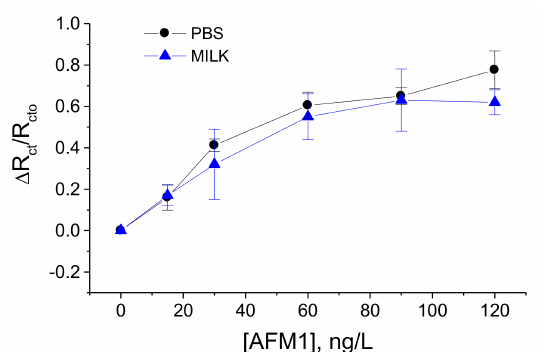
Figure 6. Plot of the relative changes of R ct values vs. concentration of AFM1 ( ∆ R ct /R cto = (R ct − R cto )/R cto , where R cto , R ct are charge transfer resistances without and with certain concentration of AFM1, respectively) in a PBS and in a spiked milk samples (see the legend). Results represent of 5 mM (1:1) [Fe(CN) 6 ] 3 − /4 − as a redox probe.